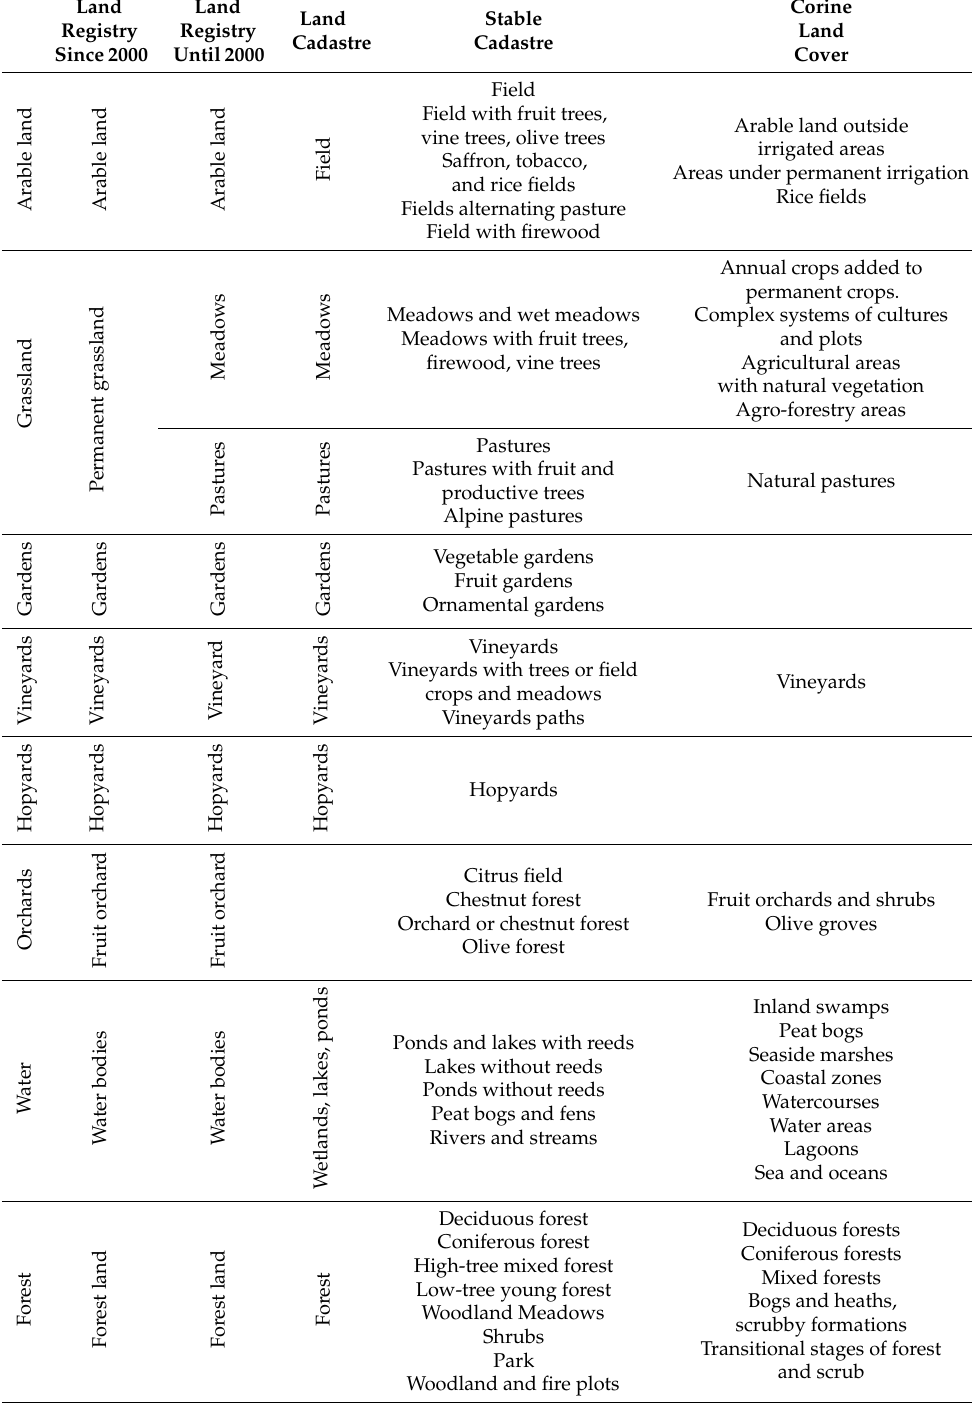
Table A1. Comparison of individual land use categories over the period under review by type of source files and map